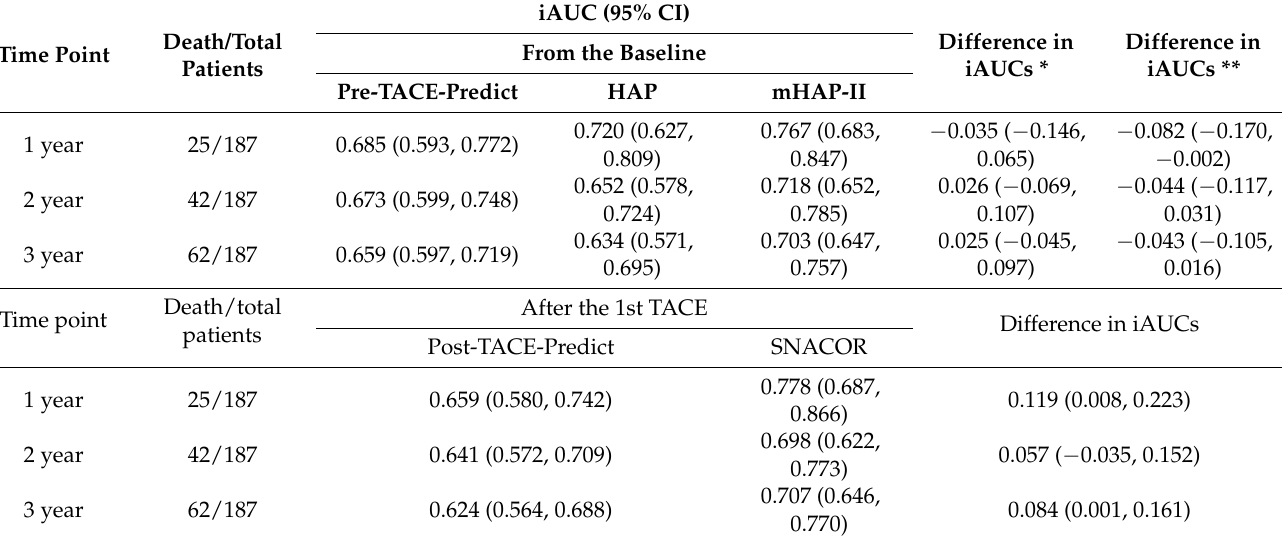
Table 6. Predictive performance of prognosis prediction models from the baseline and after the 1st